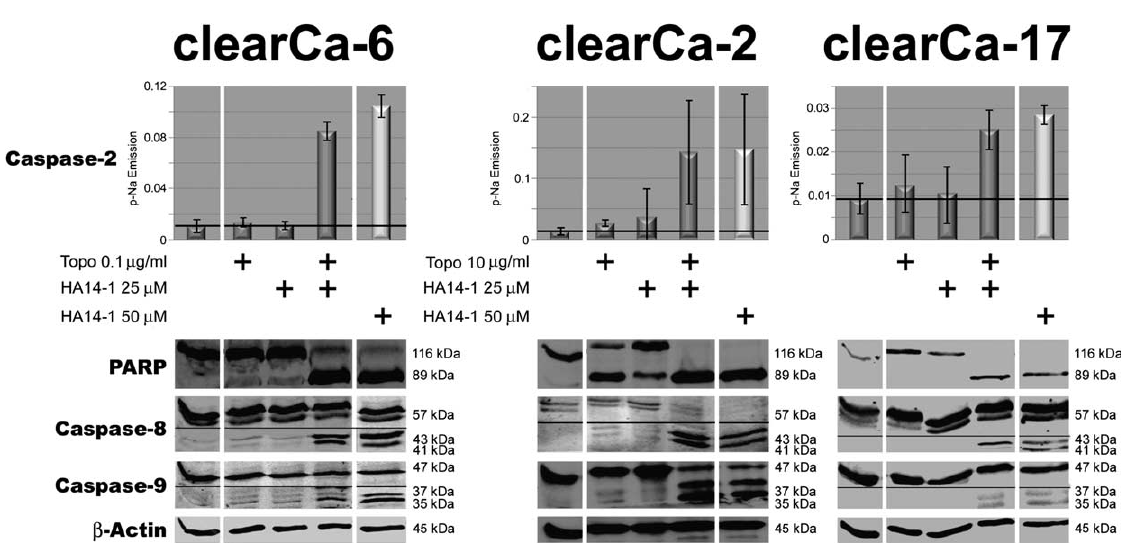
Fig. 7. HA14-1 is able to synergistically enhance activation of the initiator caspases-2, -8 and -9 as well as PARP-cleavage in all RCC cell lines. Cotreatment of the sensitive cell line clearCa-6 with Topotecan (0.1 µg/ml) and HA14-1 in a dose inducing apoptosis just weakly (25 µM) for 12 h after pretreatment with HA14-1 (25 µM) for 2 h induced a synergistically enhanced PARP-cleavage as well as caspase-2, caspase-8 and caspase-9 activation compared to separate treatment with Topotecan (0.1 µg/ml for 12 h) and HA14-1 (25 µM for 14 h) alone. In the moderately sensitive cell line clearCa-2 cotreatment with Topotecan (10 µg/ml) and HA14-1 in a dose (25 µM) barely inducing apoptosis for 24 h after pretreatment with HA14-1 (25 µM) for 2 h induced a synergistically enhanced caspase-2, caspase-8 and caspase-9 activation compared to separate treatment with Topotecan (10 µg/ml for 24 h) and HA14-1 (25 µM for 26 h) alone. Since Topotecan treatment (10 µg/ml) alone already induced a subtotal PARP-cleavage after 24 h a synergistic cleavage of PARP could not be seen after cotreatment with HA14-1. In the resistant cell line clearCa-17 cotreatment with Topotecan (10 µg/ml) and HA14-1 in a sublethal dose (25 µM) for 24 h after pretreatment with HA14-1 (25 µM) for 2 h induced PARP-cleavage as well as caspase-2, caspase-8 and caspase-9 activation whereas separate treatment with Topotecan (10 µg/ml for 24 h) and HA14-1 (25 µM for 26 h) alone could not induce PARP-cleavage or caspase-2, caspase-8 and caspase-9